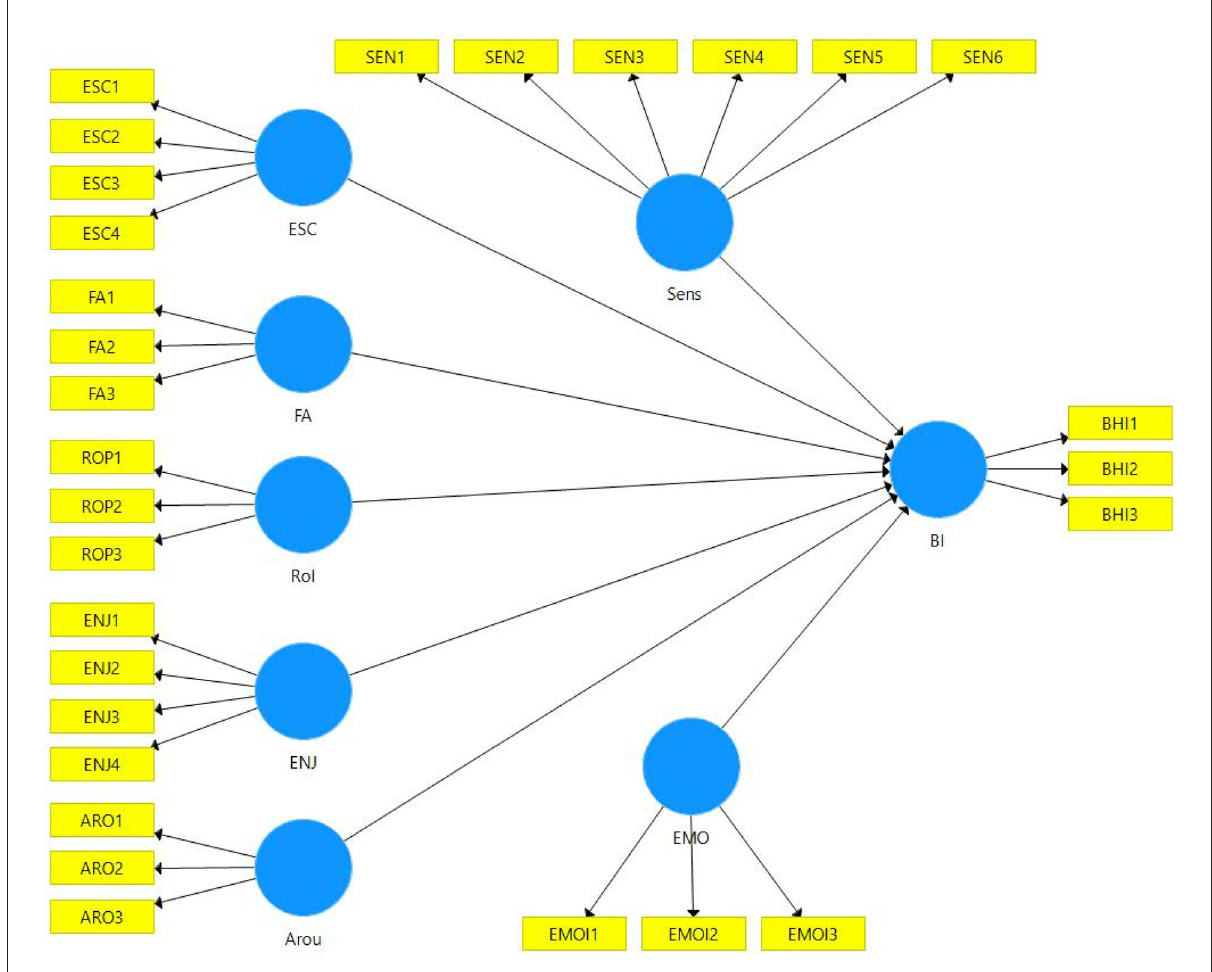
FIGURE1 The study conceptual